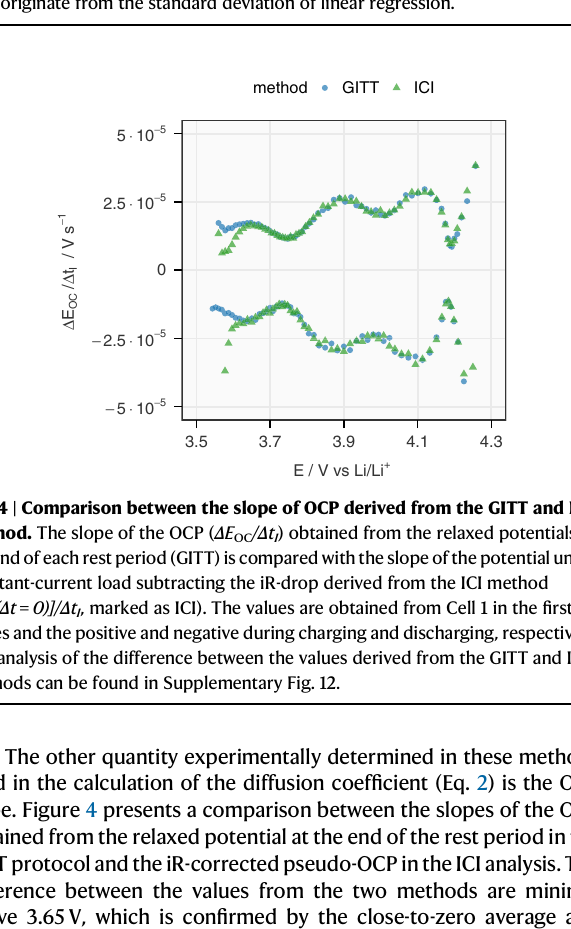
used in the calculation of the diffusion coef fi cient (Eq. 2) is the OCP slope. Figure 4 presents a comparison between the slopes of the OCP obtained from the relaxed potential at the end of the rest periodinthe GITTprotocolandtheiR-correctedpseudo-OCPintheICIanalysis.The difference between the values from the two methods are minimal above 3.65V, which is con fi rmed by the close-to-zero average and minimal standard deviation (0.086) of the relative difference in Sup- plementary Fig. 11. The deviation at low SoC is presumably linked to the high charge transfer resistance discussed above, which increases the time-constant of electrochemical double-layer charging and thus interferes with the resistance determination of the ICI method.